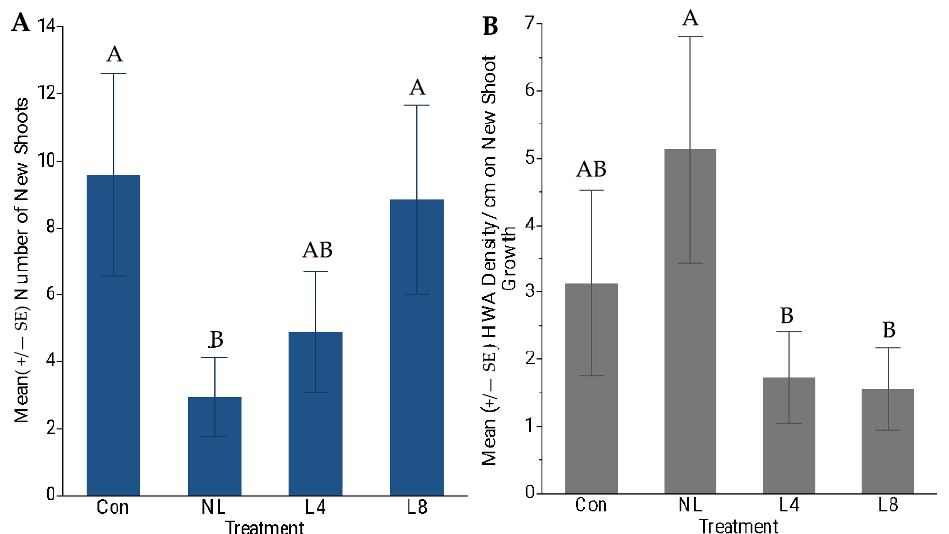
Figure 3. Experiment 2––External Tree Measurements. ( A ) Mean (+/− SE) number of new shoots across treatments. Different letters above standard error bars indicate significant ( p < 0.05) differ- ences, Tukey post hoc adjustment. ( B ) Mean (+/− SE) HWA density (HWA/cm) on new shoot growth across treatments. Different letters above standard error bars indicate significant ( p < 0.05) differ- ences, Tukey post hoc adjustment. All measurements were taken on eastern hemlock. Con = no predators at low HWA densities (<1/cm), NL = no predators at moderate to high HWA densities (<1 HWA/cm), L4 = 4 and L8 = 8 L. nigrinus at moderate to high HWA densities. Table 4. Zero-inflated linear mixed model analysis on the effect of treatment on new shoot growth production and new shoot growth length. Treatment